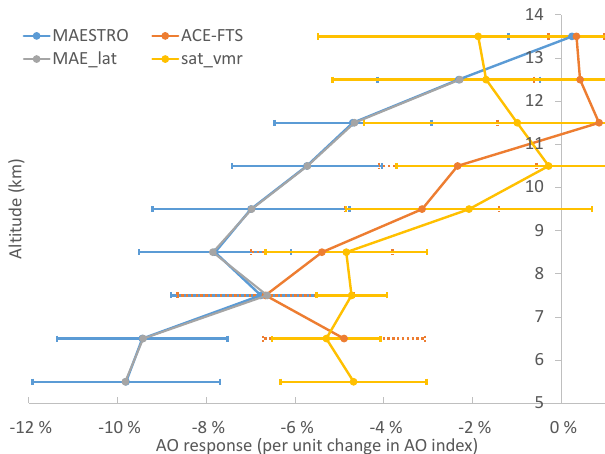
Figure 10. Time series of water vapour relative anomalies observed by ACE-MAESTRO (“MAE”) and ACE-FTS at 6.5 ± 0.5km in winter months (January–March). Slight differences in sampling ex- ist between the two instruments due to the requirement for >20 ob- servations per month per altitude